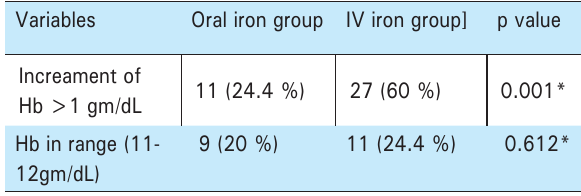
Table 3. Result of increment of